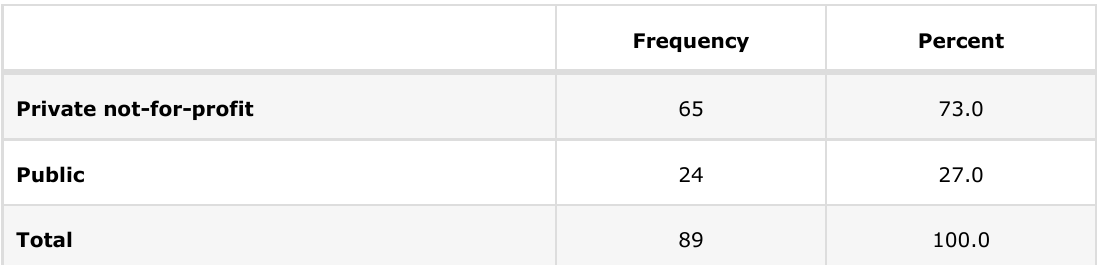
Institutions by Financial